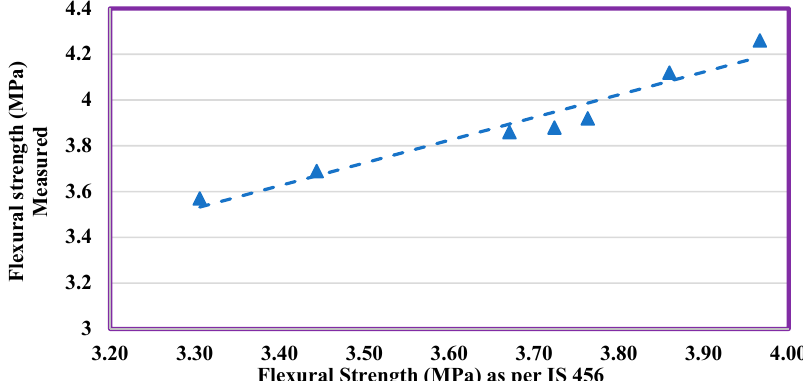
Figure 12. Measured flexural stress vs. computed flexural strength.